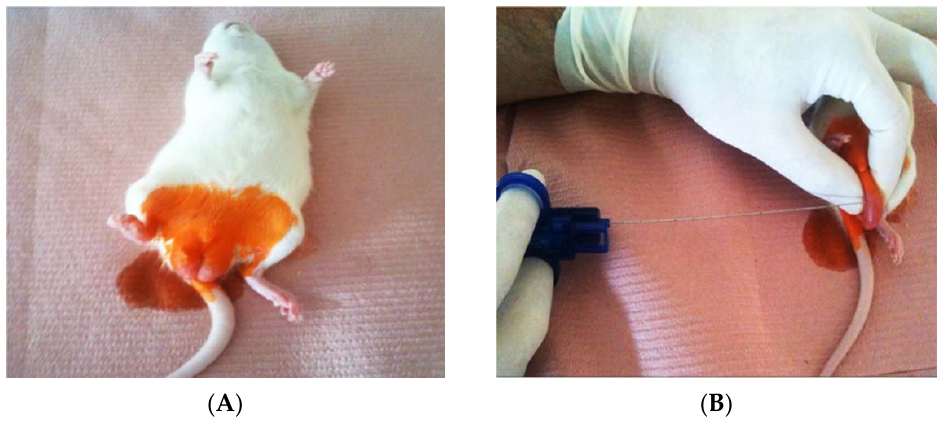
Figure 1. Intraoperative finding during the punch biopsy: ( A )—Anesthetized rat after preparation of the operating field; ( B )—Puncture of the testes using biopty gun.